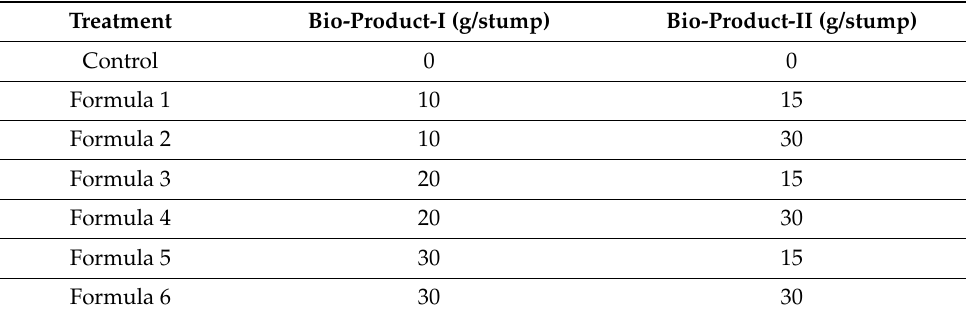
Table 2. Composition of the bio-products used in in the